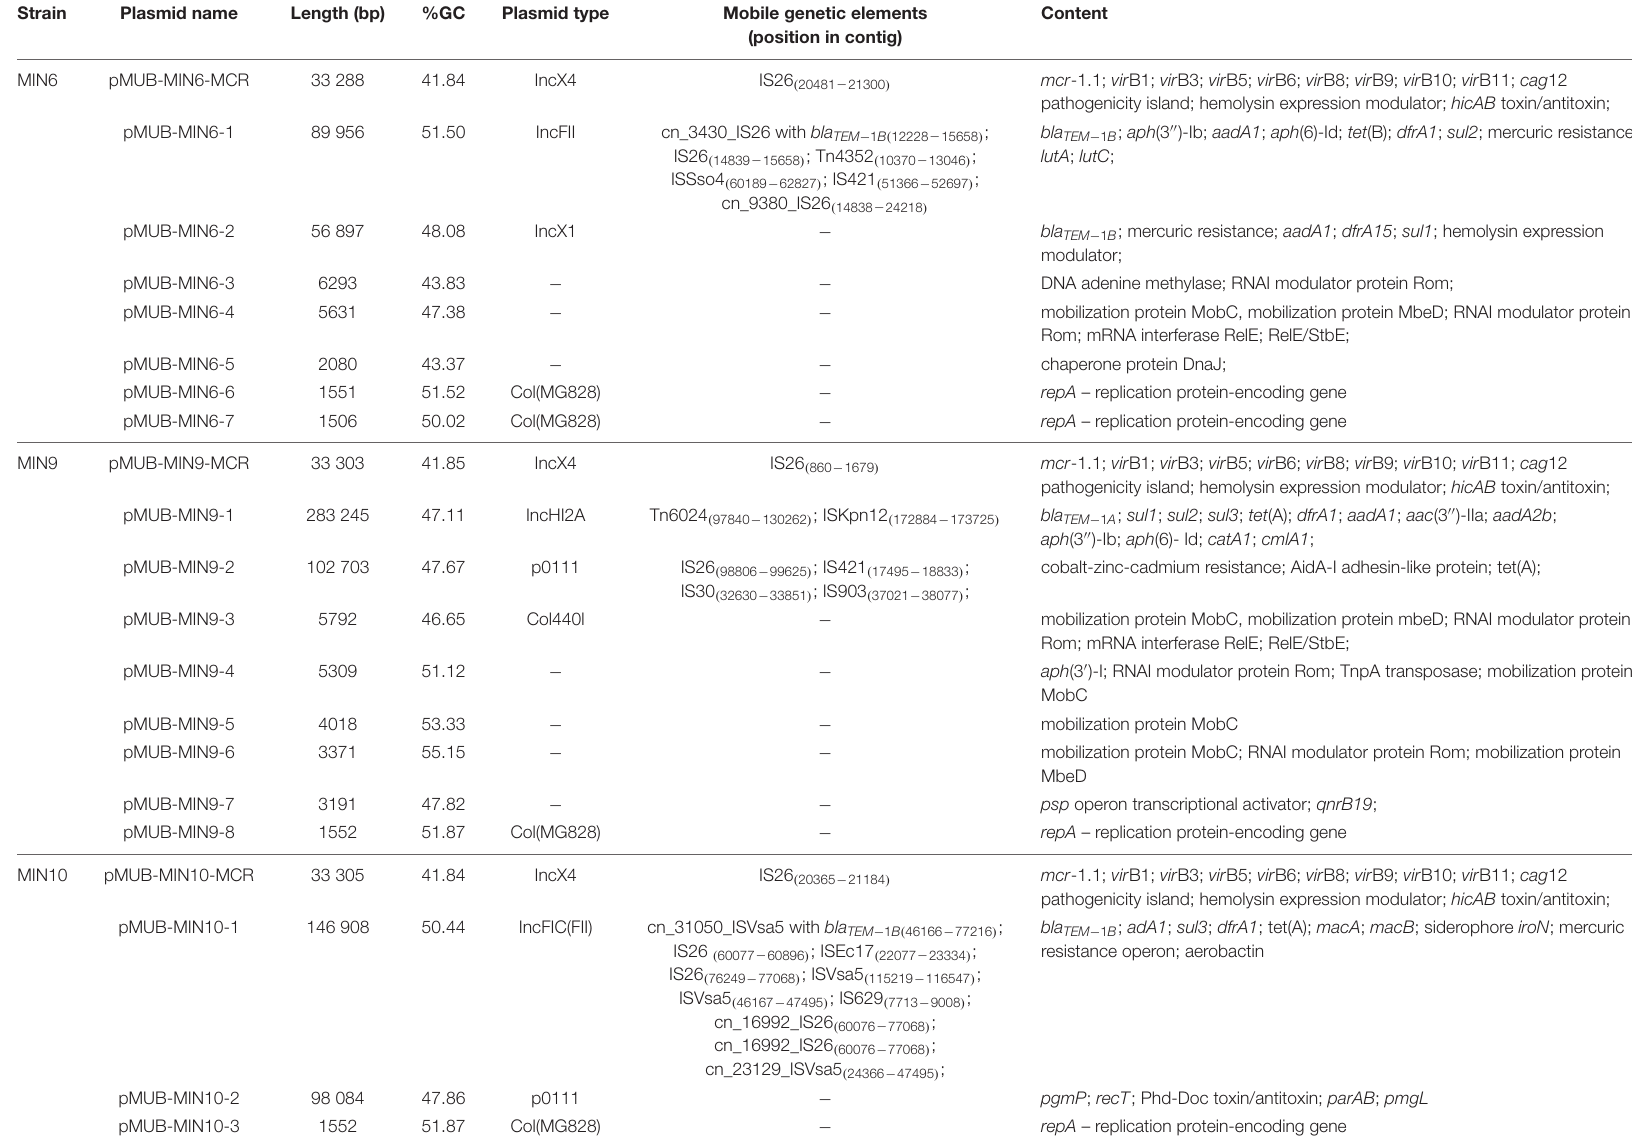
TABLE 4 | Plasmids harbored by six extraintestinal colistin-resistant E. coli strains. Strain Plasmid